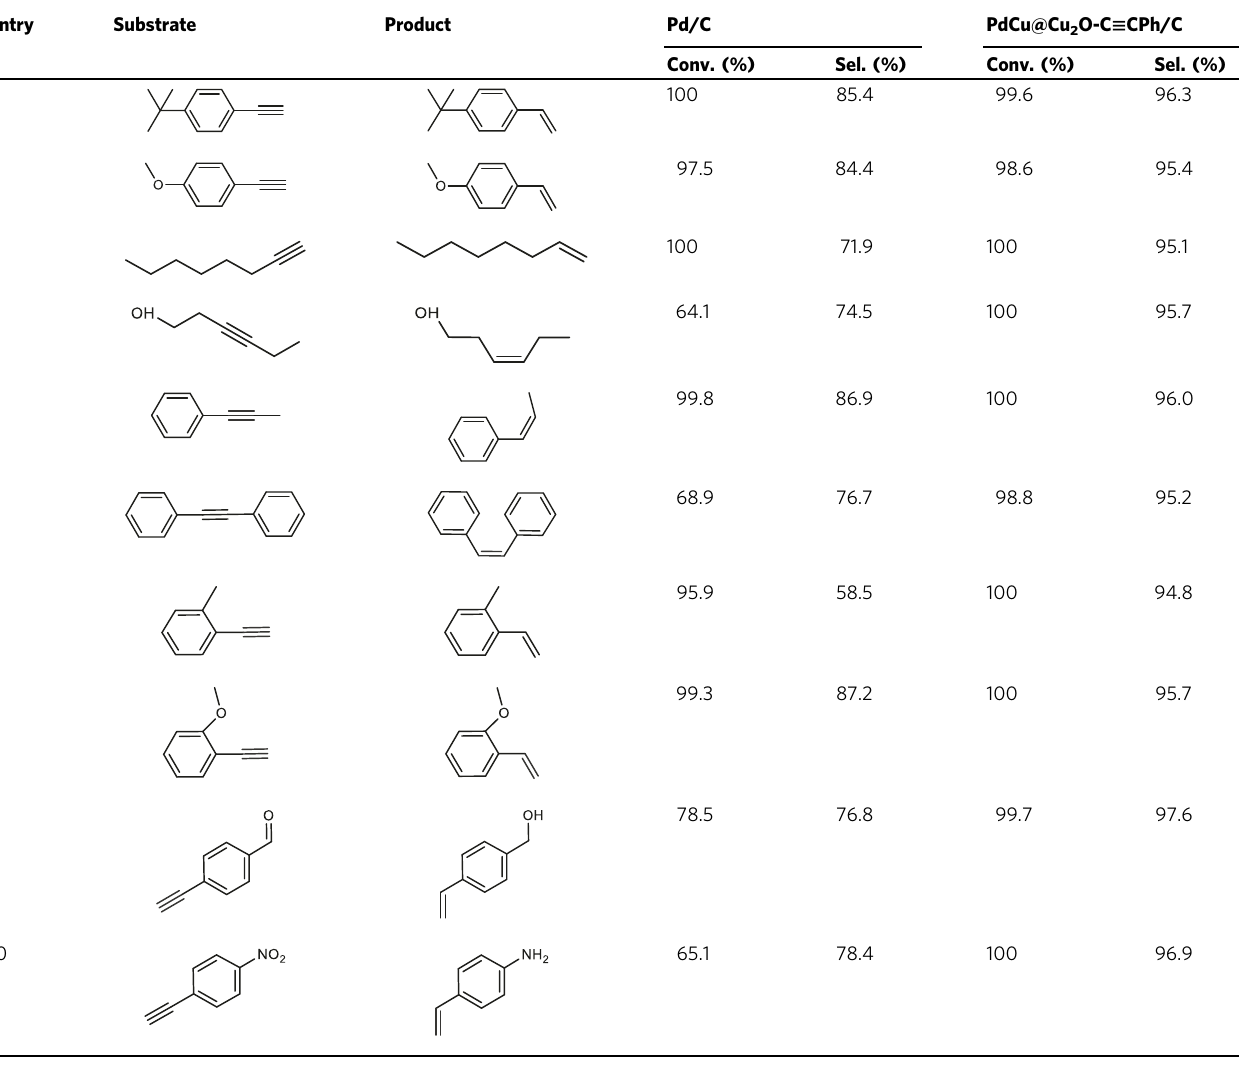
Table 1 Comparison of the catalytic performances of PdCu@Cu 2 O-C ≡ CPh/C and references. Entry Substrate